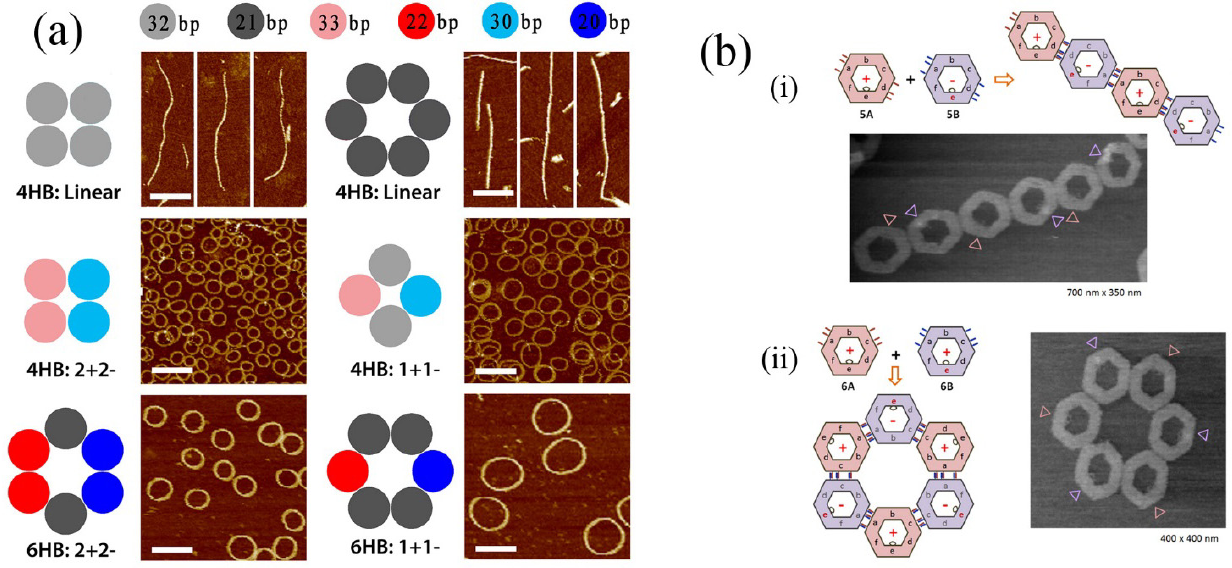
Figure 7. ( a ) Result of controlling in plane curvature of DNA helix bundles. Top panels show linear unmodified bundles. Lower panels illustrate the introduction of curvature by addition or deletion of base pairs. The number of base pairs in the self-assembling units is shown at the top. Adapted from ref. [63]. Copyright (2013) American Chemical Society. ( b ) Photoinduced self-assembly using azobenzene appended DNA nanostructures. Secondary assembly of DNA hexagons was controlled by introducing photoisomerable azobenzene moieties at the required points in DNA origami structures. Also, assembly and disassembly of the DNA hexagons could be reversibly achieved by photoirradiation. Adapted from ref. [64]. Copyright (2012) American Chemical